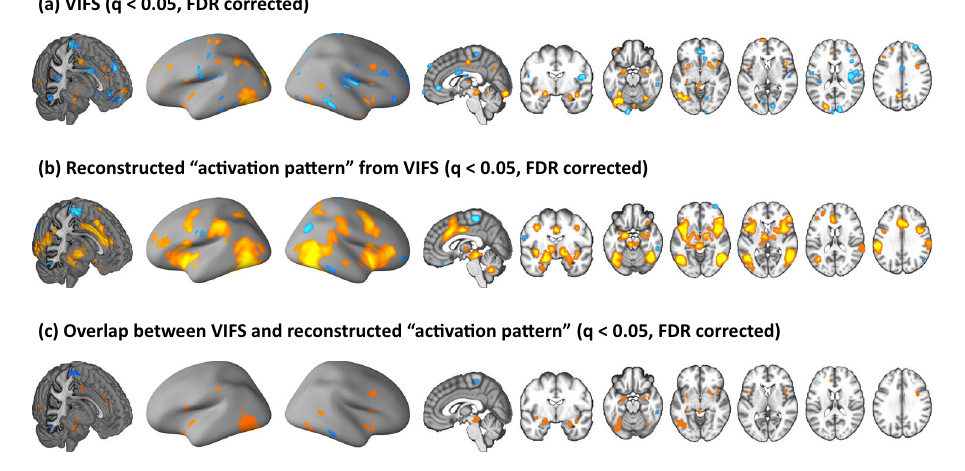
Fig. 3 Subjective experience of fear is associated with and predicted by distributed brain regions. a shows the thresholded VIFS. b depicts the threshholded transformed ‘ activation pattern ’ from the VIFS. c shows the overlap between VIFS and transformed ‘ activation pattern ’ . All images are thresholded at q < 0.05, FDR corrected. Hot color indicates positive associations ( a ) or weights ( b ) whereas cold color indicates negative associations ( a ) or weights ( b ). VIFS visually induced fear